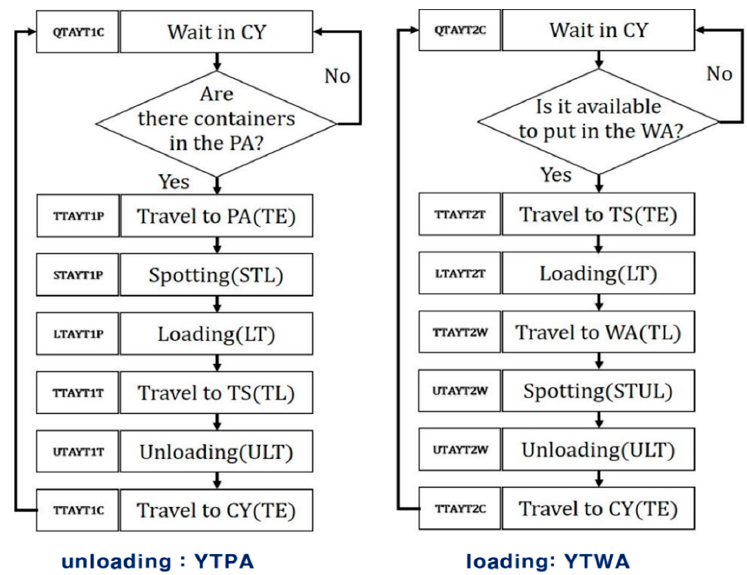
Figure 12. Simulation algorithm for yard tractor. YTPA and YTWA represent the yard tractors at the unloading and loading waiting areas, respectively.